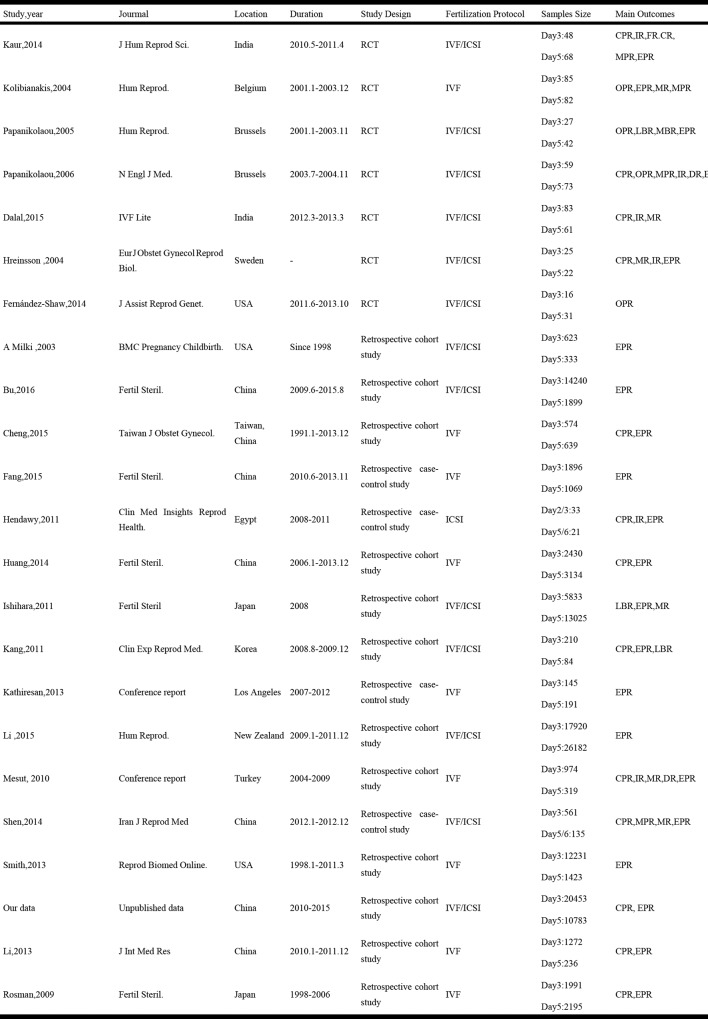
Characteristics of all studies included in the systematic review.RCT: randomized controlled trial; IVF: in vitro fertilization; ICSI: intracytoplasmic sperm injection; CPR: Clinical pregnancy rate; EPR: ectopic pregnancy rate; OPR: Ongoing pregnancy rage; LBR: Live birth rate; MR: Miscarriage rate; DR: Delivery rate; IR: Implantation rate.